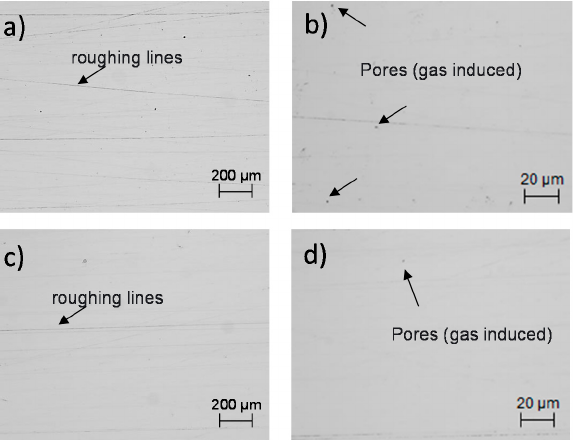
Figure 3. Metallographic images of the SLMed 316L SS horizontal and vertical surfaces showing porosity. Images: ( a ) (50X) and ( b ) (500X) XY plane, and ( c ) (50X) and ( d ) (500X) XZ plane.